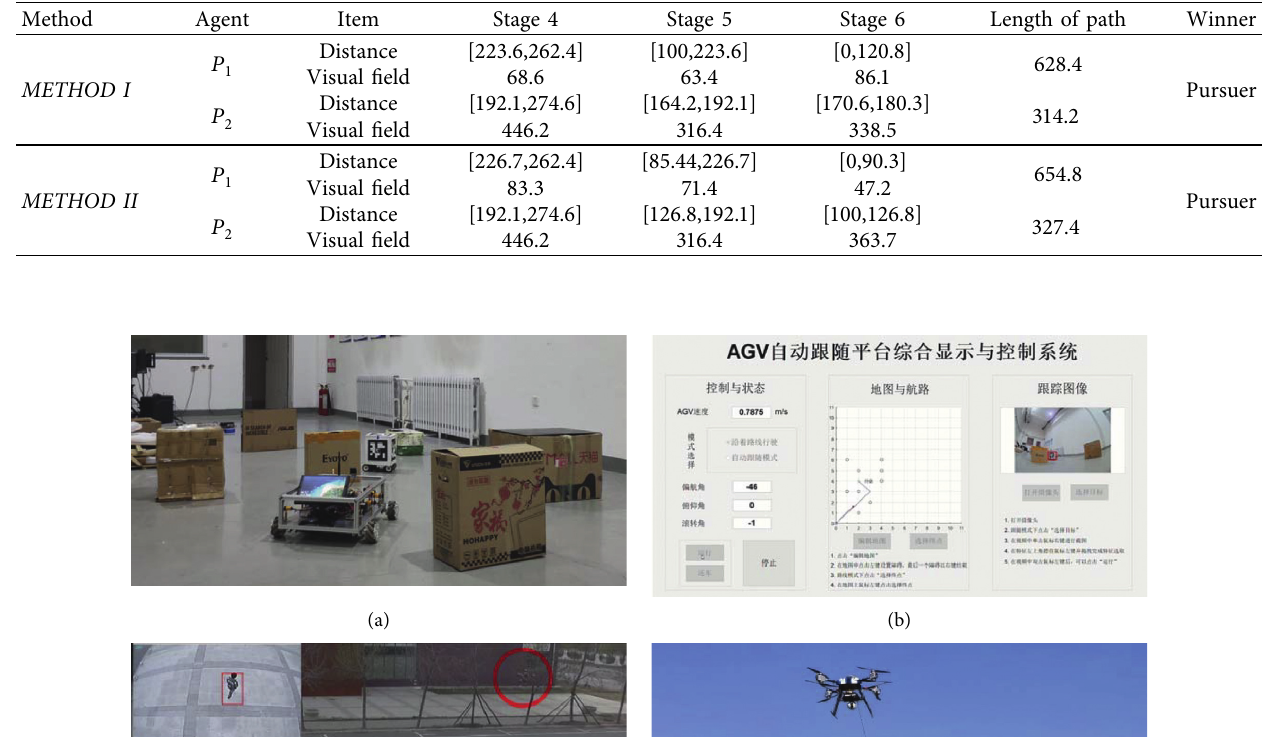
Table 2: Comparison between METHOD I and METHOD II.